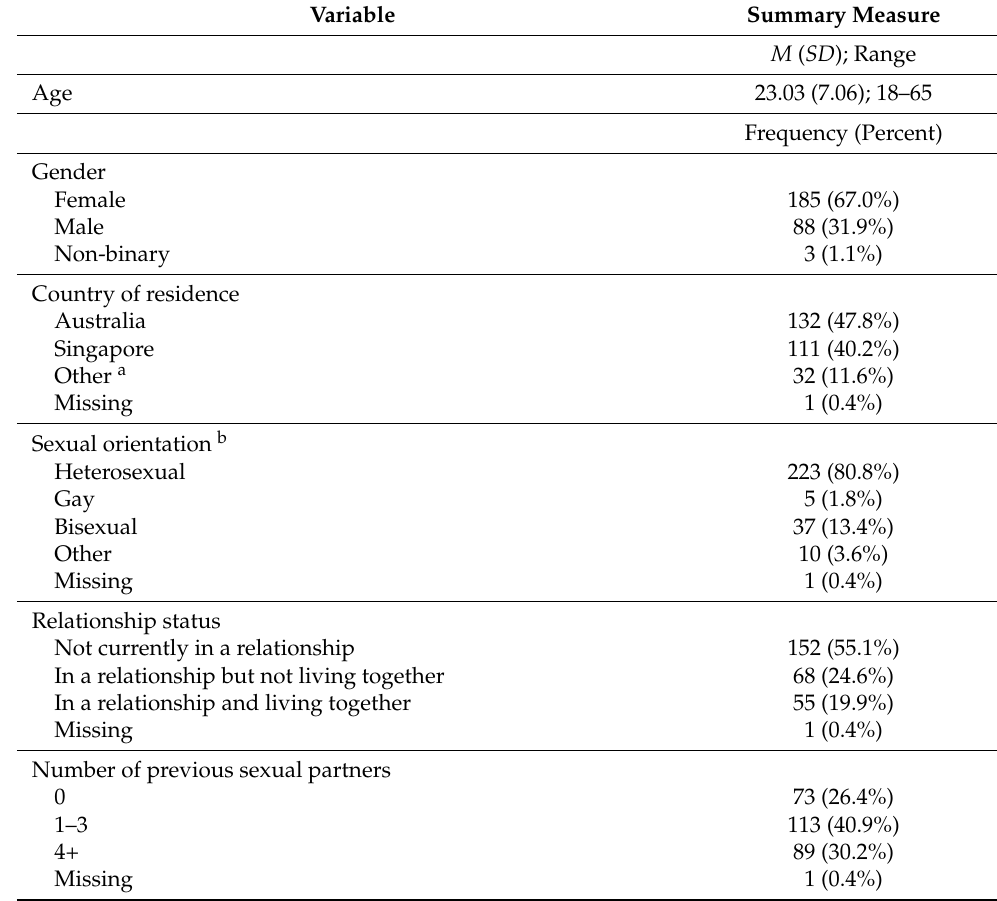
Table 2. Demographic characteristics of final sample ( N =